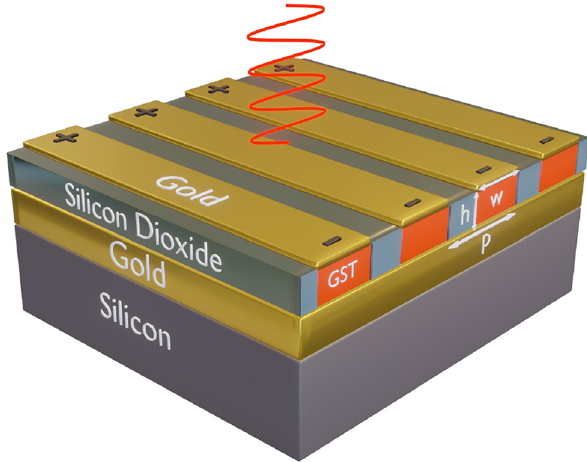
Figure 1: Three-dimensional illustration of the proposed electrically reconfigurable metasurface. The metasurface structure consists of patterned Au nanoribbons on the GST nanostripes, which are spacers, deposited on an Au back separated from each other by SiO 2 reflector. The entire structure resides on a Si substrate with 500 μ m thickness. A voltage signal can be applied between two end-faces of the Au nanoribbon to partially convert the corresponding GST nanostripe in the desired nanoantenna from the amorphous to the crystalline states (or any state in between). The periodicity of the meta-atom is p = 550 nm while the width and thickness of each Au nanoribbon are w = 340 nm and 30 nm, respectively. The thickness of GST nanostripes is h = 180 nm. Throughout this paper, all geometrical dimensions ( p , w , and h ) remain